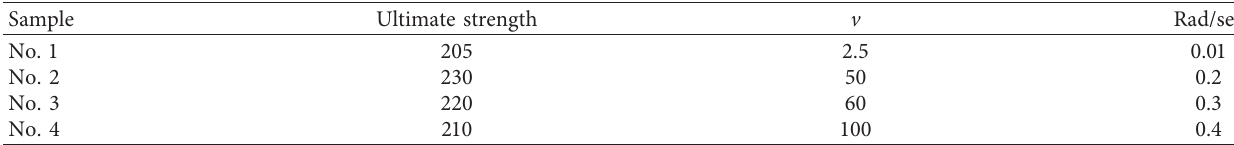
Table 2: Results obtained from a steel shear wall built with